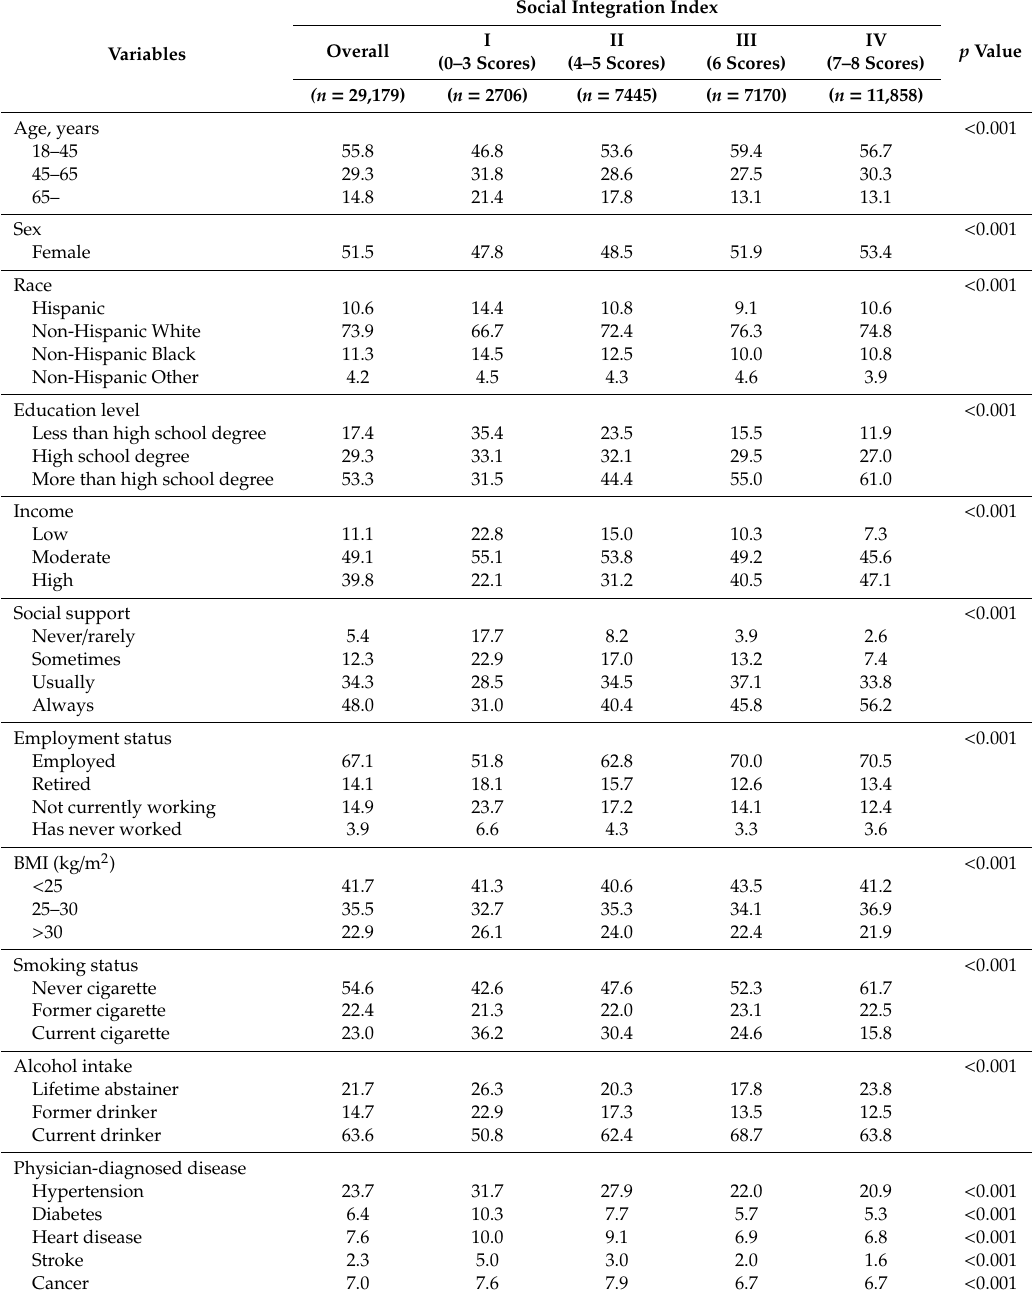
Table 1. Baseline characteristics based on social integration index in 2001 US National Health Interview Survey Participants With 15-year Vital Status Ascertainment ( n =